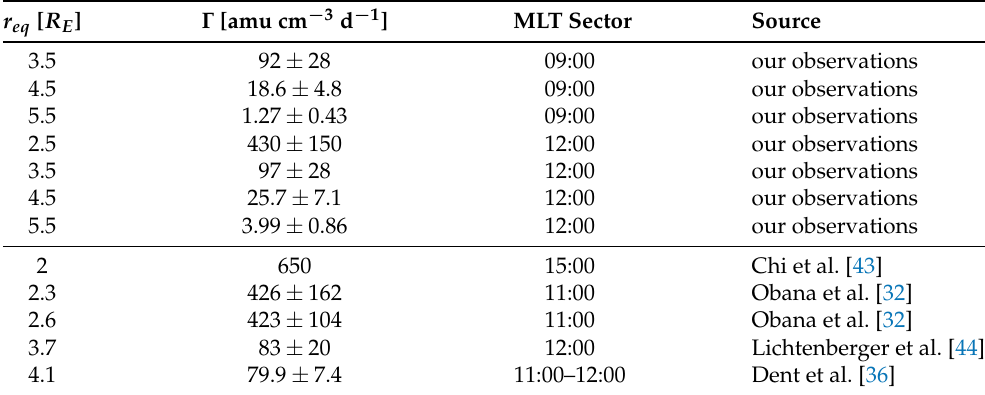
Table 2. Day-to-day refilling